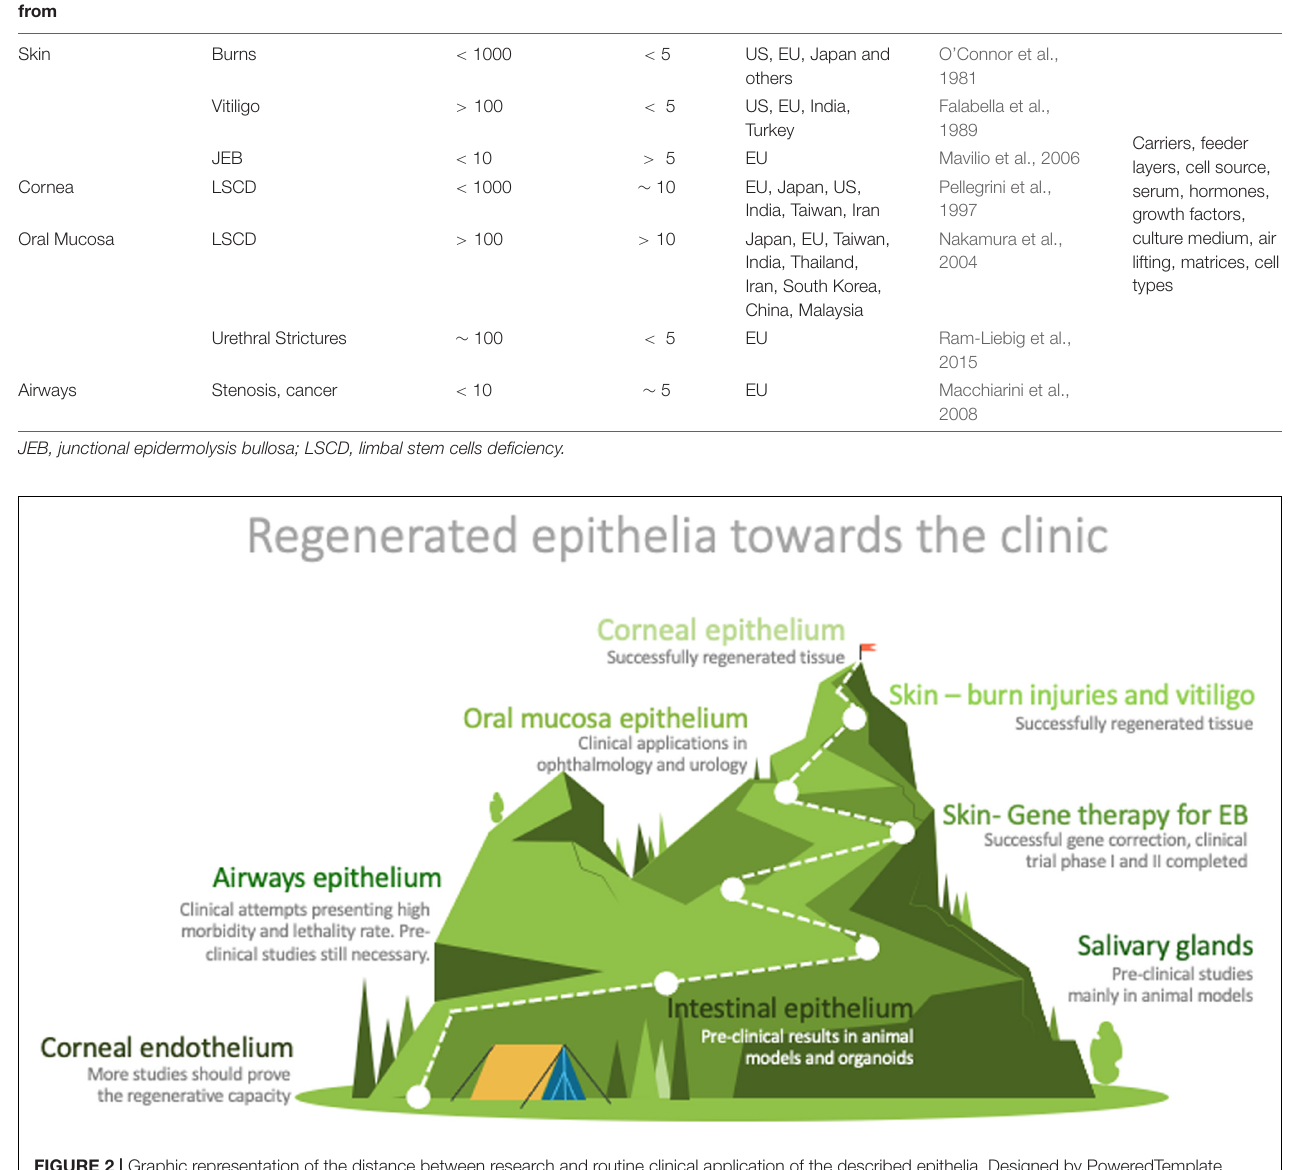
exhaustive cell characterization, together with specific stem cell identification, are instrumental for self-renewal and long-term tissue